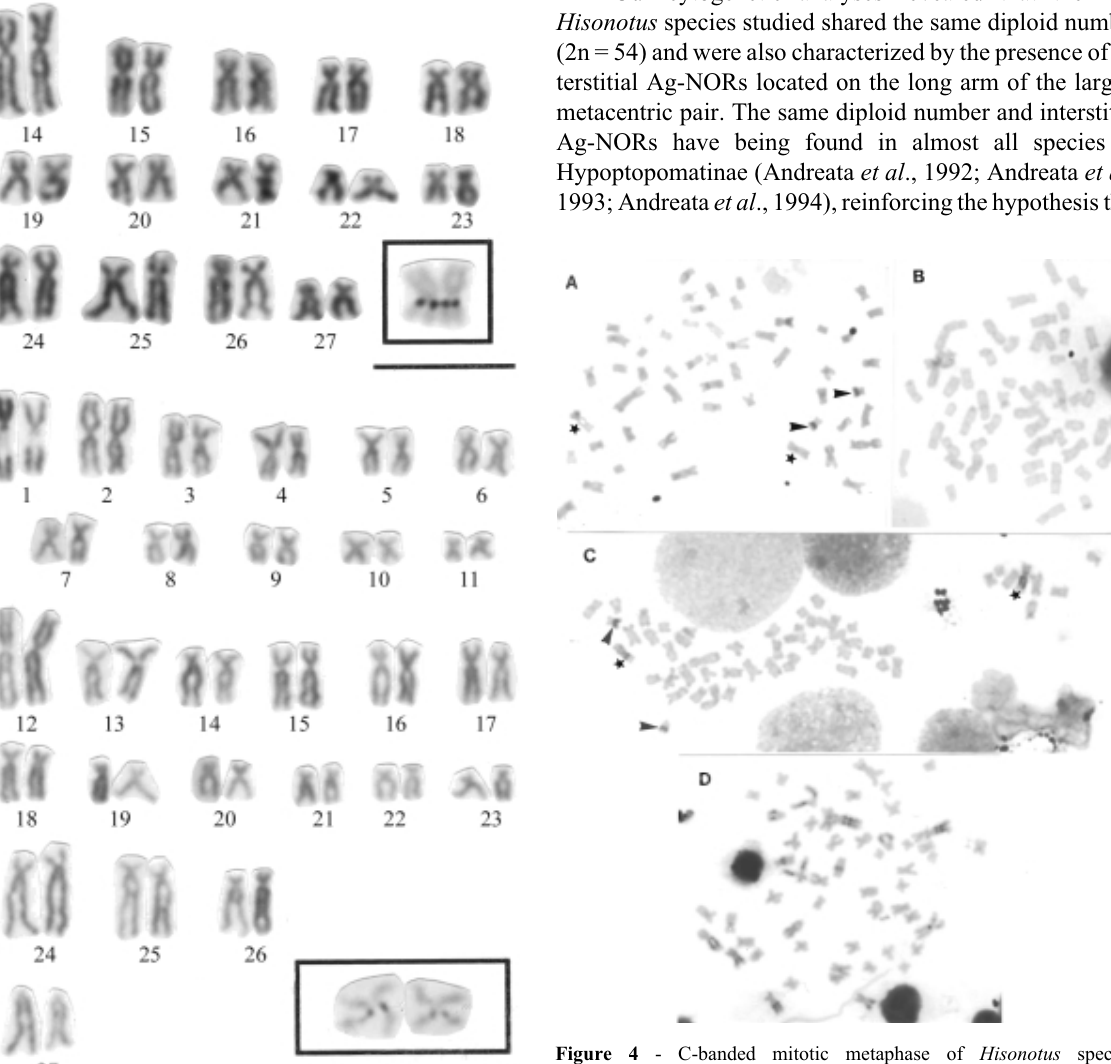
Figure 4 - C-banded mitotic metaphase of Hisonotus species. A = Hisonotus species A from Salesópolis (São Paulo State); B = H. nigricauda from Eldorado do Sul (Rio Grande do Sul State); C = Hisonotus species D from Pindamonhangaba (São Paulo State); and D = H. leucofrenatus from Jaraguá do Sul (Santa Catarina State). Arrows point to marker chromosomes shared by two species. Stars indicate Ag-NOR-bearing